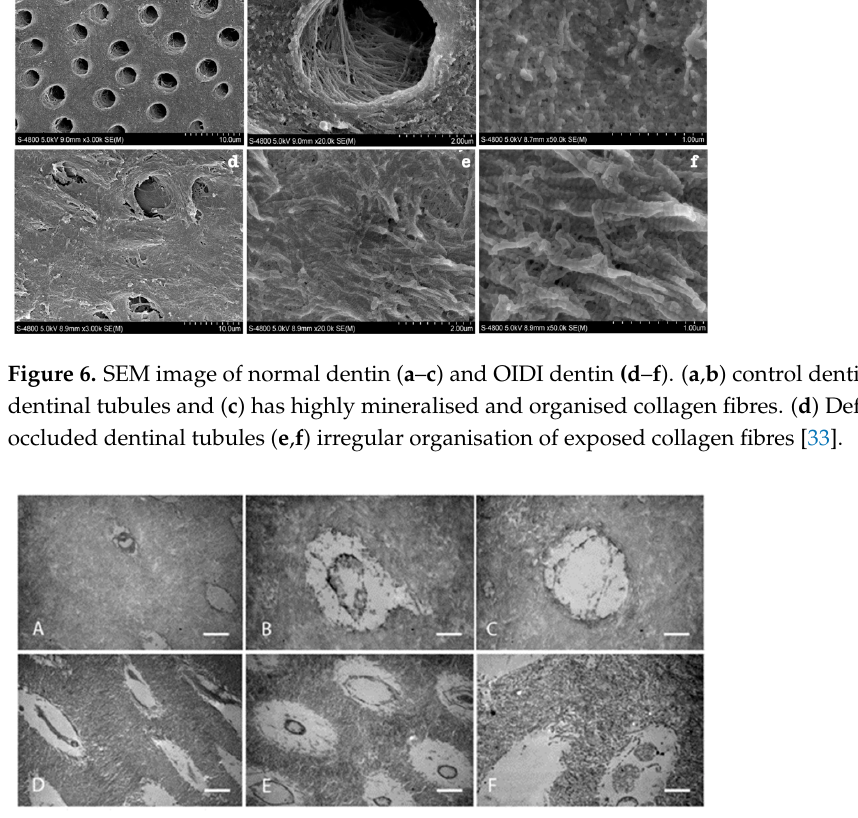
Figure 7. TEM images of normal and OIDI dentin. Normal condensed collagen matrix ( A – C ). Irregular organisation of circular collagen fibres in a loose abnormal matrix ( D – F ) [34].